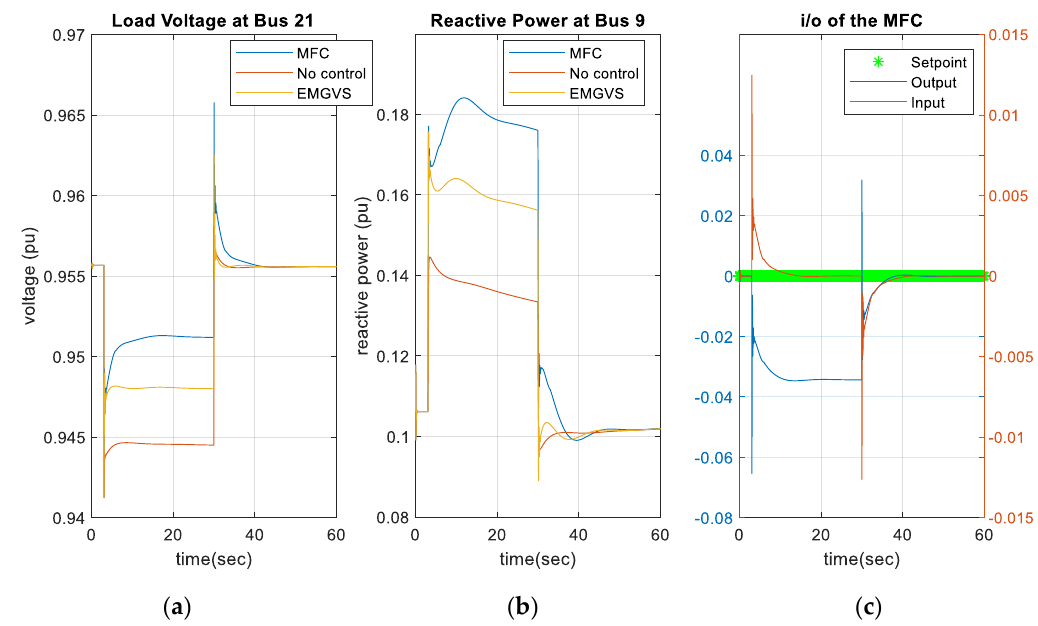
Figure 15. Simulation results for the IEEE 21-bus microgrid system with two PE-based DERs and one SG-based DER under a 25% load increase at all load buses ( Case 1 )—( a ) load voltage at bus 21; ( b ) reactive power at bus 9, and ( c ) i/o of the MFC. Energies 2020 , 13 , 3838